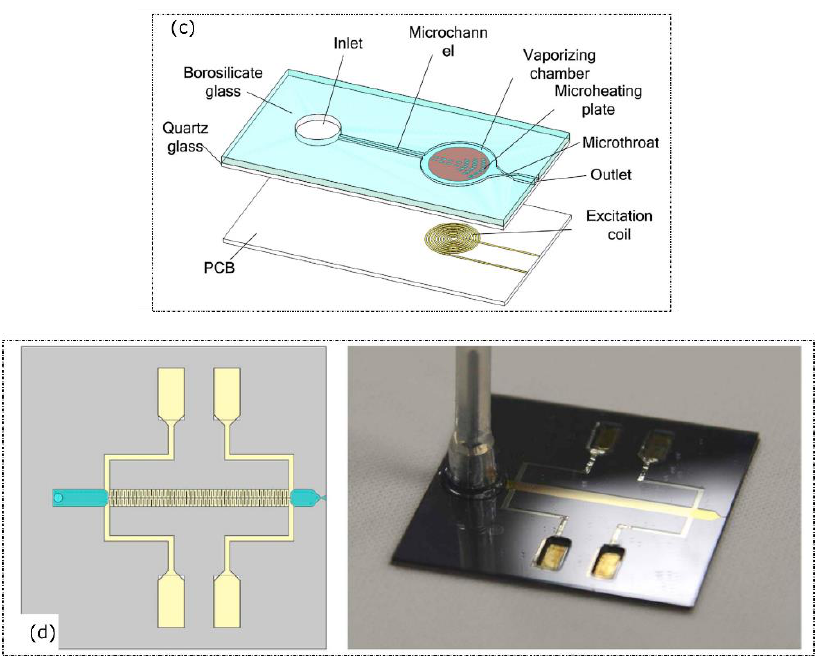
Figure 5. Manufactured VLMs in single channel configuration: ( a ) Karthikeyan et al. [20]; ( b ) Cheah and Low [21]; ( c ) Liu et al. [23]; ( d ) Kwan et al. [24]. Table 2. Comparison between the measured performance of existing VLMs. g 0 = 9.81 m/s 2 is the gravitational acceleration at sea